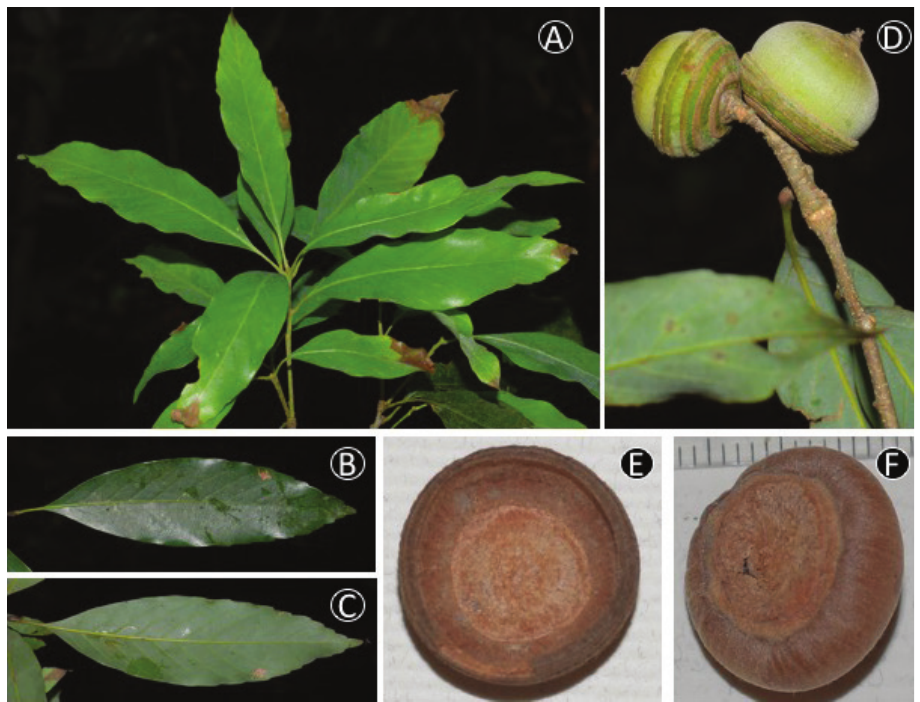
Figure 5. Image of Quercus bella Chun & Tsiang. A Leafy twig B Adaxial side of mature leaf C Abaxial side of mature leaf D Infructescense and mature fruit ( A–D from Yahara et al. V6981 (DLU, FU)) E Inside of cupule F Bottom of nut ( E–F from Binh et al. V6038